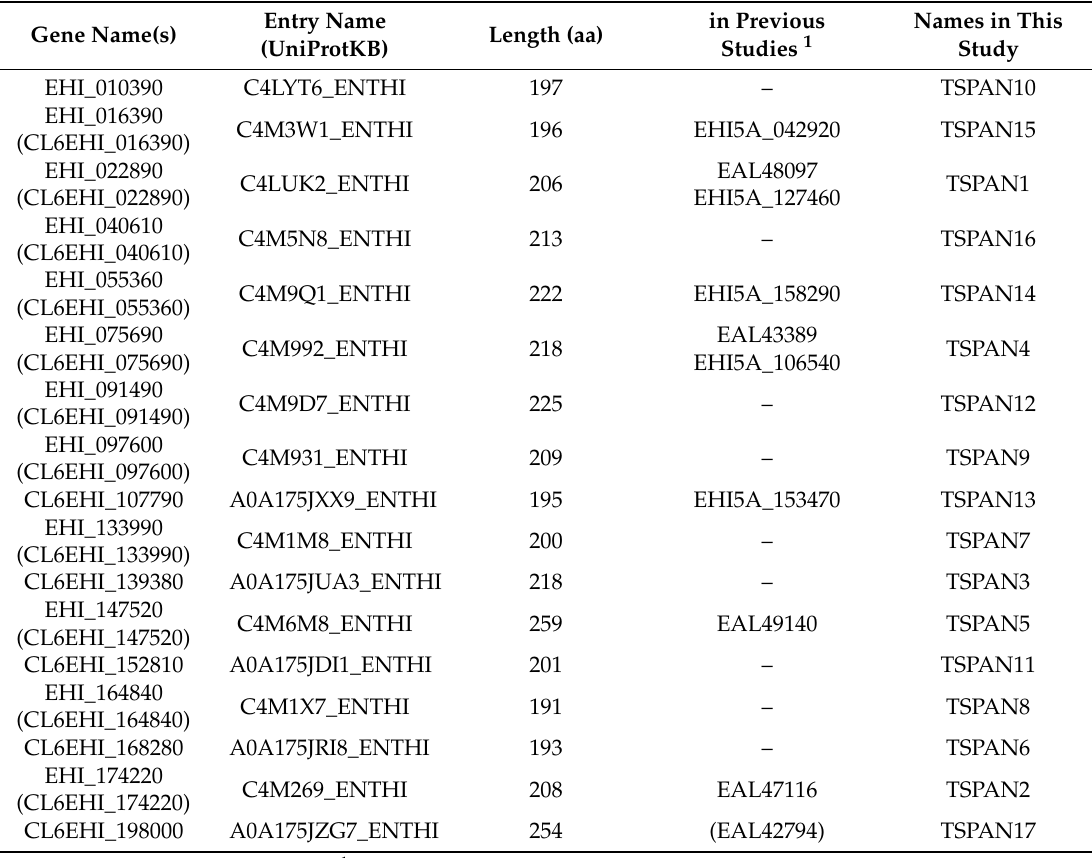
Table 1. A list of known and potential tetraspanins in E. histolytica